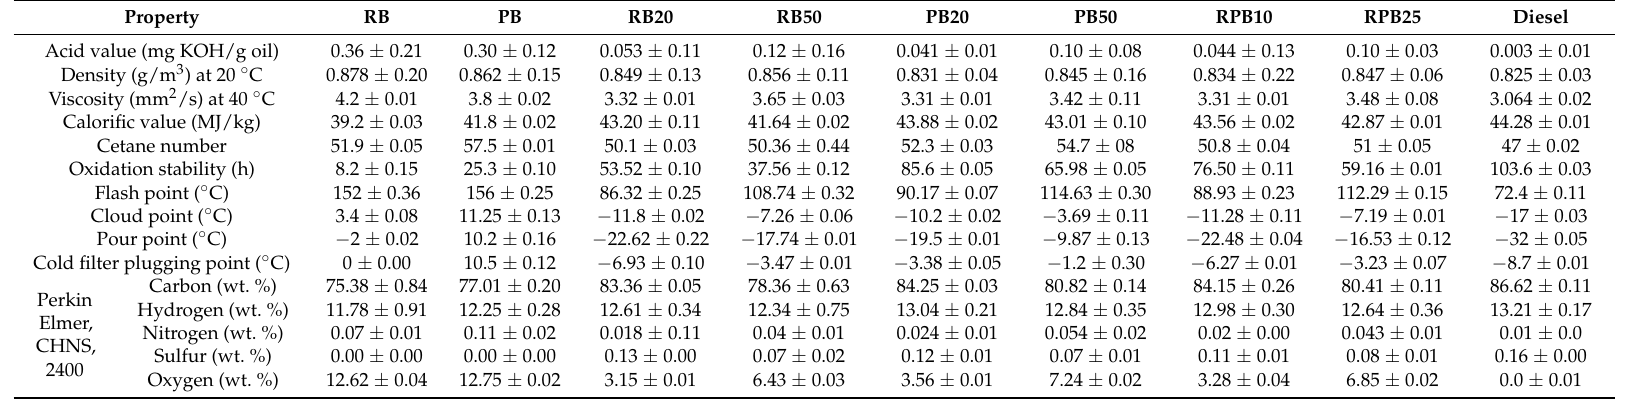
Table 6. Measured fuel properties of tested biodiesels and their